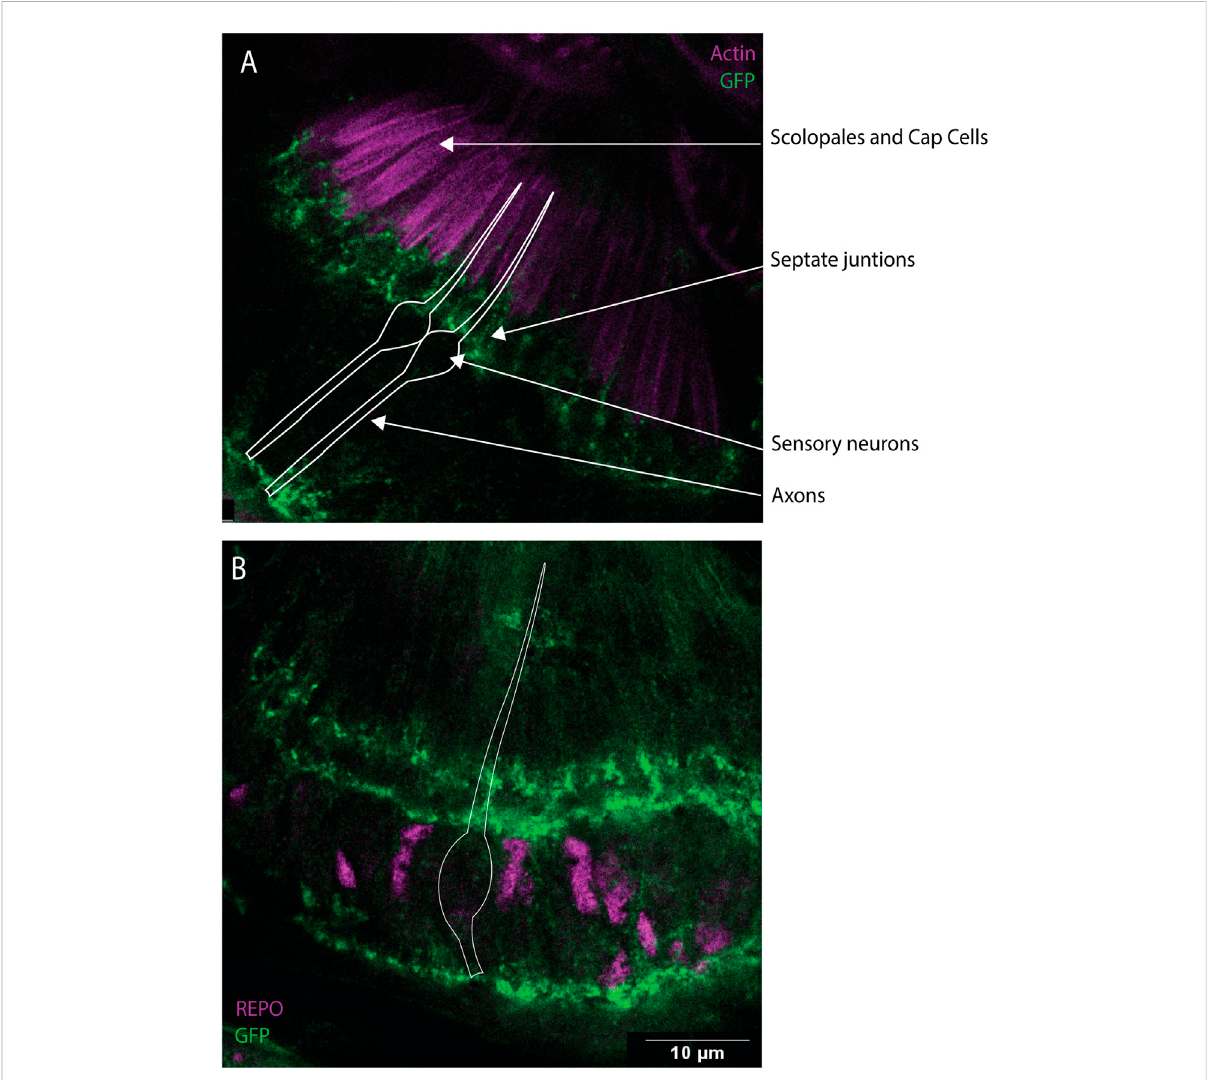
FIGURE 7 DysexpressioninJO,mainlyinthescolopaleandligamentcells.Immuno fl uorescenceperformedonpupalantennaefrom fl ylineDyb-GFP. (A) Immuno fl uorescenceperformedusinganti-GFPantibodies(green)andphalloidin(magenta),whichmarkstheactinbundlespresentinthescolopale and cap cells. This identi fi ed the expression of Dys protein in the basal part of the scolopale cells. (B) Immunostaining performed using anti-REPO (magenta) and anti-GFP antibodies (green). Dys expression is concentrated in three speci fi c locations, the basal part of the scolopale cell, the top part of the ligament cells at sites predicted to be in contact with the scolopale cells (septate junctions), and in the basal area of the ligament cells where they connect with the JO cuticle. The white diagram represents the shape of the sensory neuron. Scale bars: 10 μ